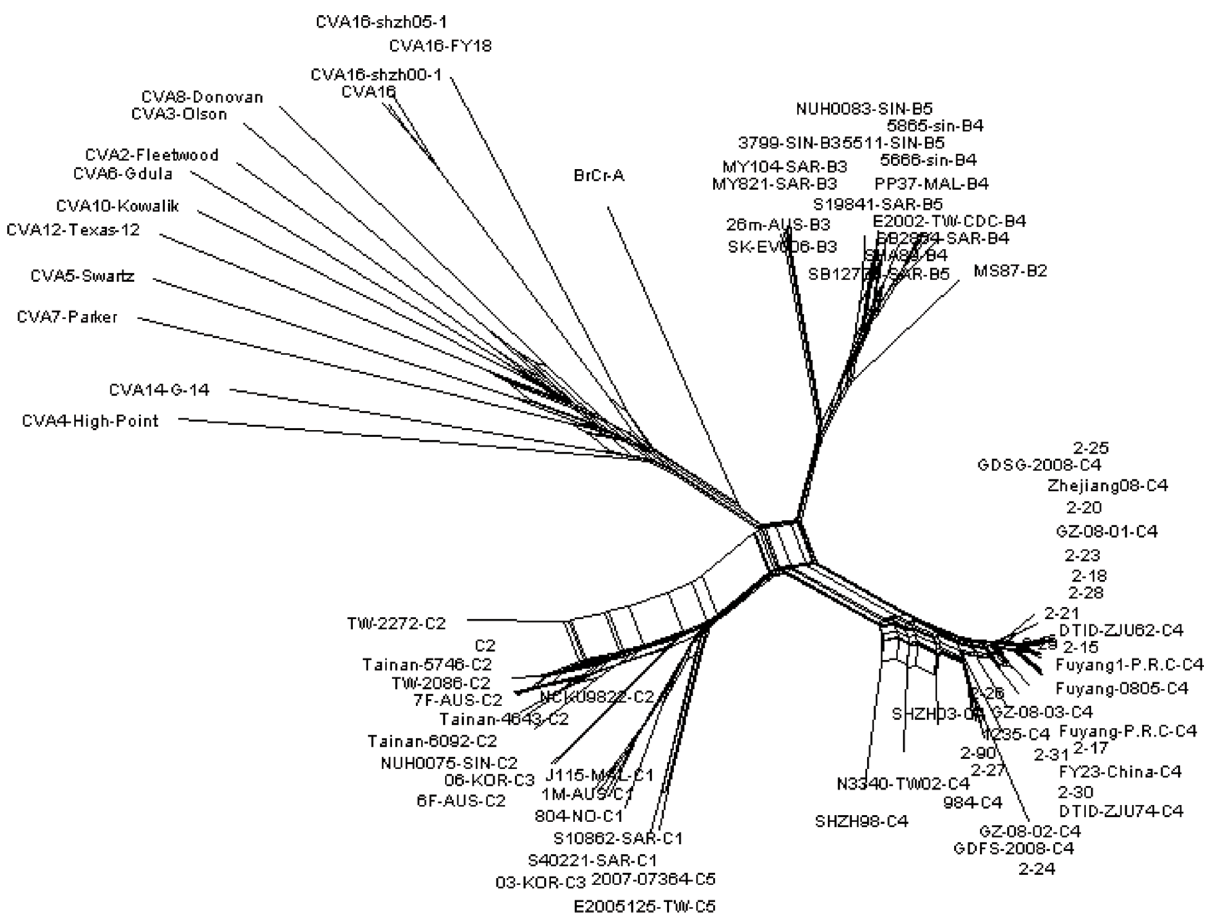
Figure 7. Phylogenetic tree analysis of different Taiwanese EV71 isolates using split tree method with nucleotide sequences from VP1-2A-2B region (2281 nucleotides in length). Bootstrap analysis was performed using 1000 times.